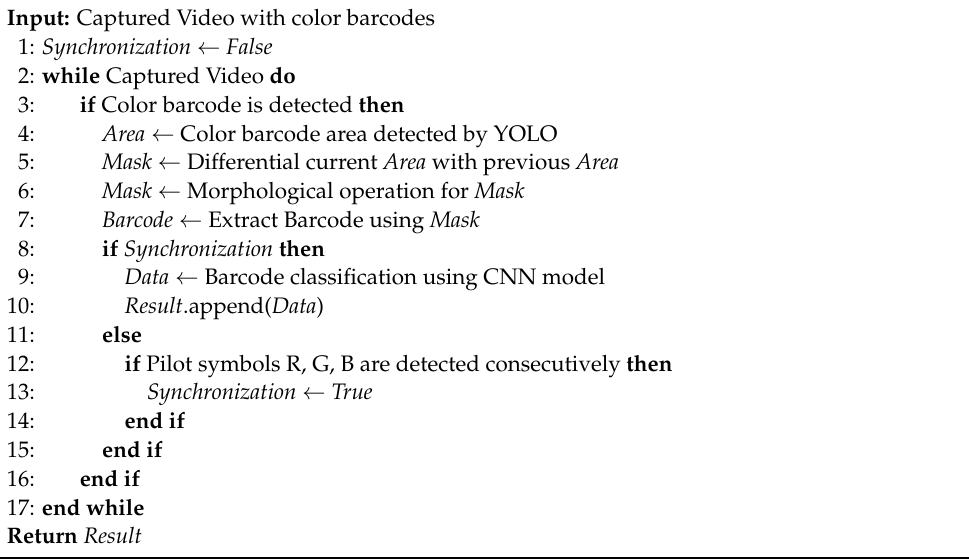
Algorithm 1: The entire process of DeepCCB −